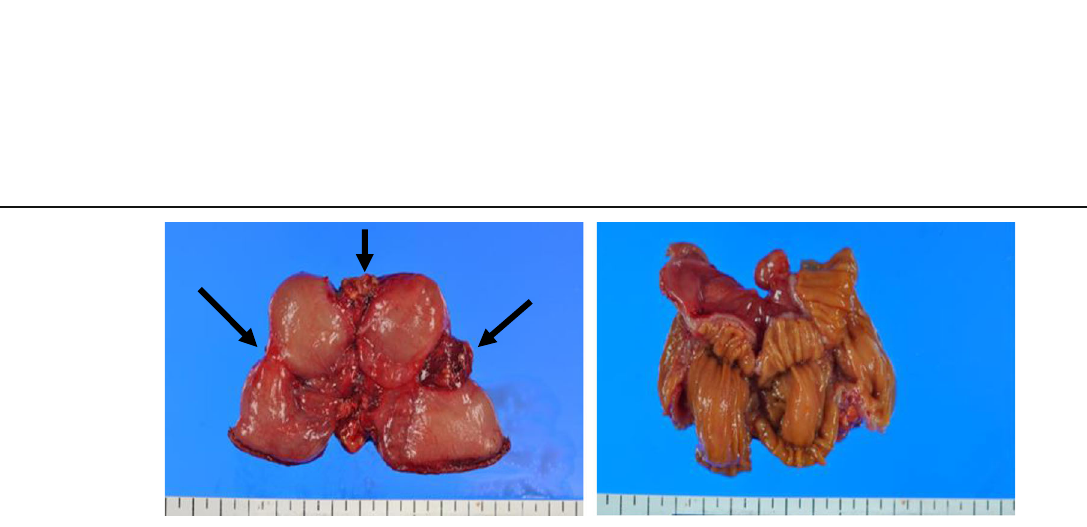
Fig. 4 Resected specimen showing three areas of stenosis